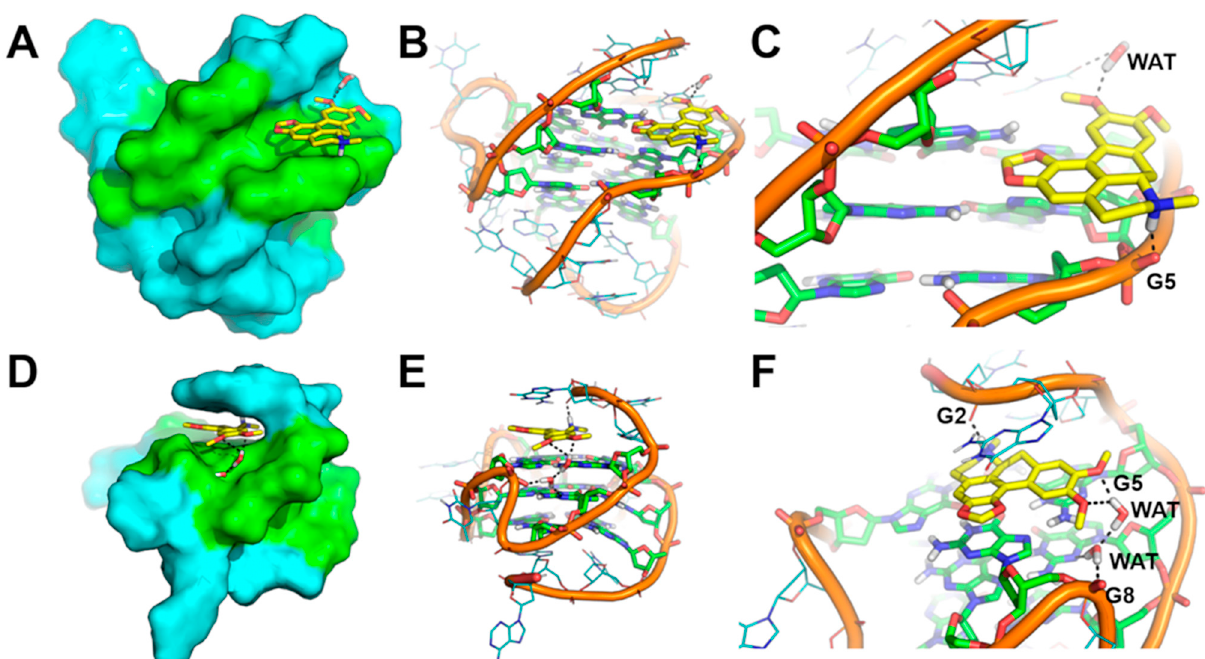
Figure 6. Representative MD structures describing the interaction between Dicentrine and tel 26 and Pu22 G ‐ quadruplexes. ( A ) Surface representation of tel 26 . ( B ) Cartoon representation of tel 26 . ( C ) Magnification of the binding mode of Dicentrine in the groove of tel 26 . ( D ) Surface representation of Pu22. ( E ) Cartoon representation of Pu22. ( F ) Magnification of the binding mode of Dicentrine on top of the G ‐ tetrad of Pu22. Nucleotides from G ‐ tetrads are colored green, other nucleotides are colored cyan. Dicentrine is shown as sticks and colored yellow. Water molecules bridging the ligand and G ‐ quadruplexes are shown as sticks. Polar contacts are highlighted by black dashed lines. Nucleotides and water molecules (WAT) involved in polar interactions with Dicentrine are labeled in panels ( C , F ).